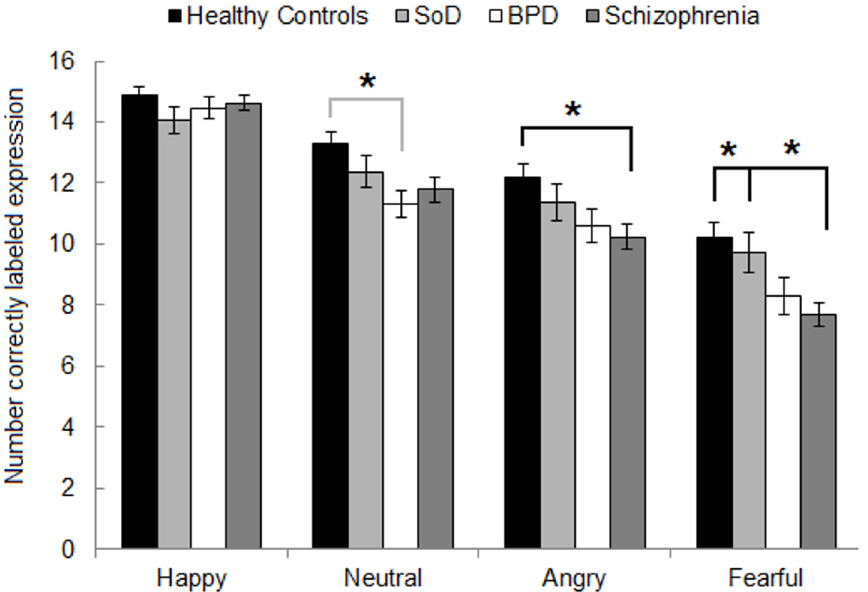
Fig 2. Number of correctly labeled faces (SEM) per emotion, per group. Asterisks reflect significant differences between groups: black for schizophrenia; grey for